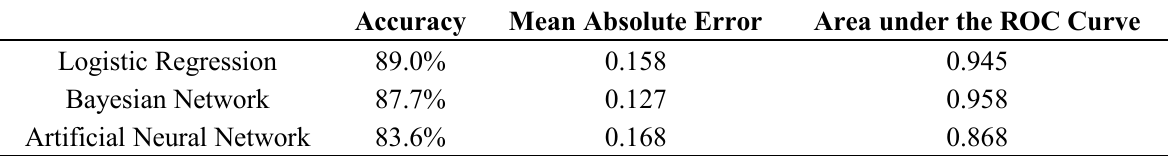
Table 3. Performance of customized mortality predictions models for ICU patients who presented with subarachnoid hemorrhage (SAH).